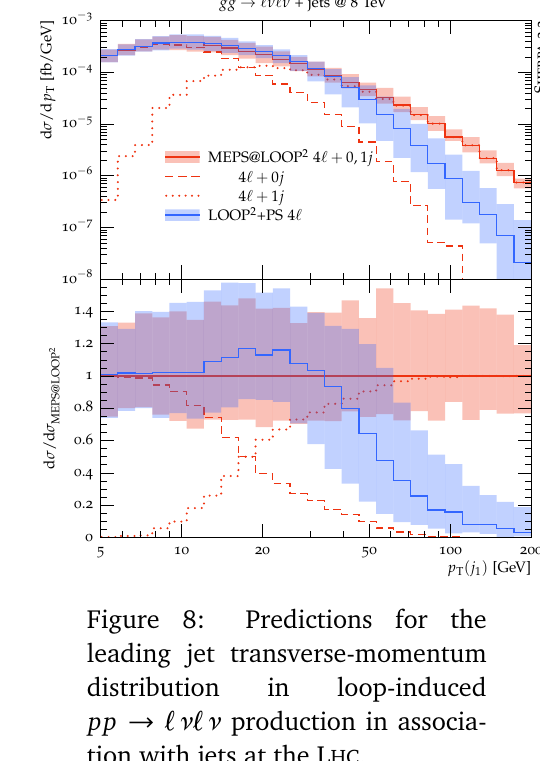
Figure 8: Predictions for the leading jet transverse-momentum distribution in loop-induced pp → (cid:96)ν(cid:96)ν production in associa- tion with jets at the L HC